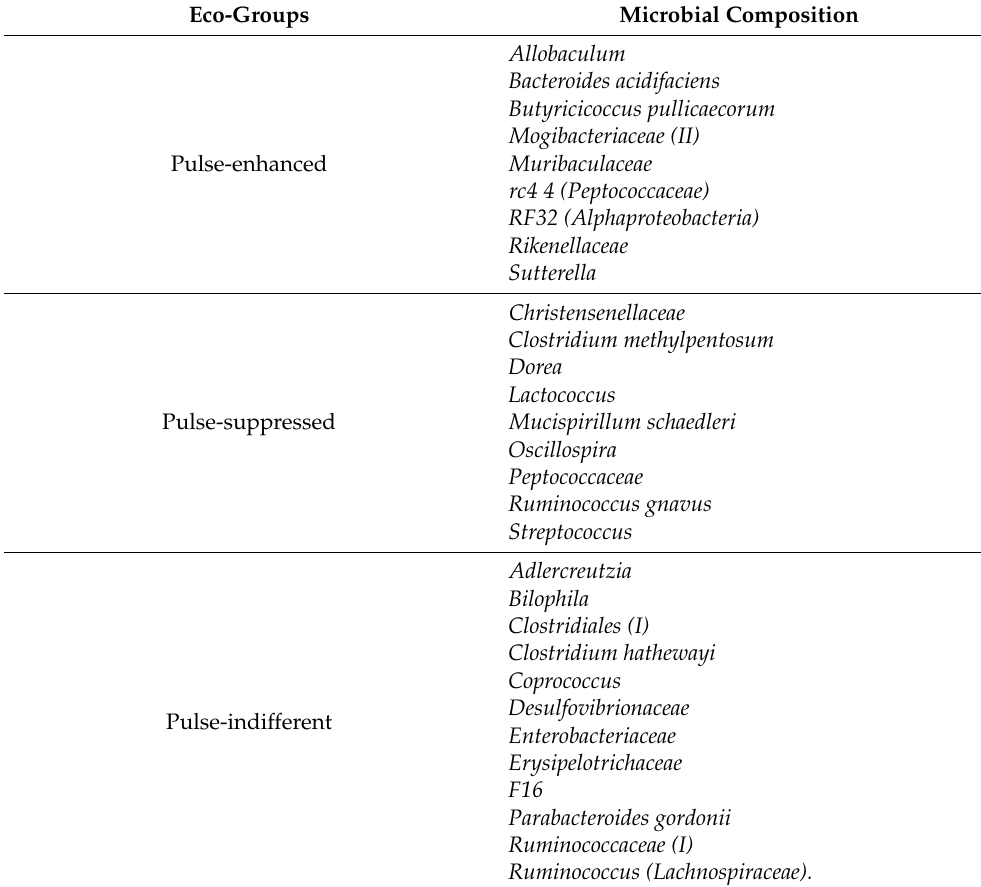
Table 4. Summary of the pulse-induced gut microbial